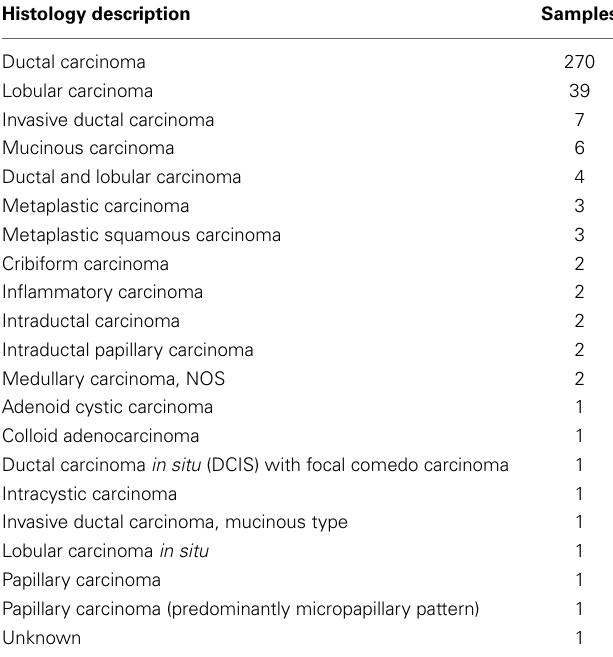
the expO breast cancer gene expression